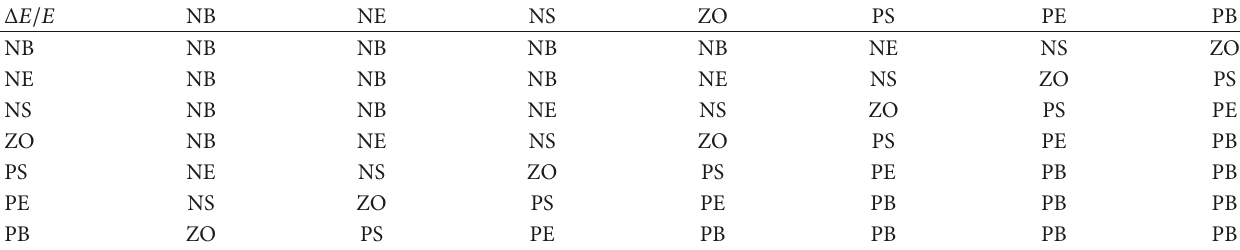
Table 3: Rule table of 𝐾𝑝 parameter fuzzy